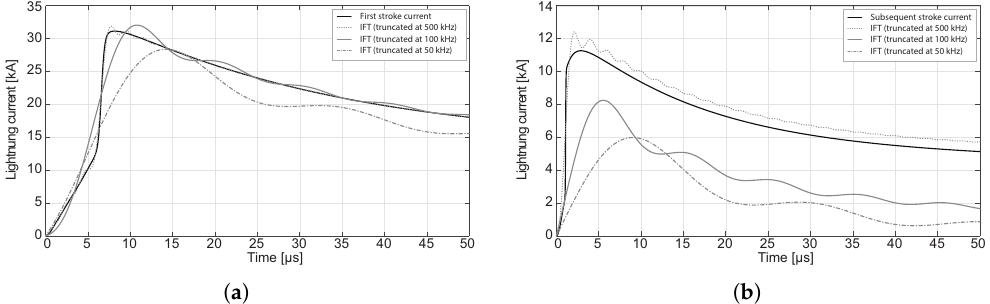
Figure 21. First and subsequent stroke currents obtained as the Inverse Fourier Transform of the frequency spectrum in Figure 20a, truncated at 500 kHz, 100 kHz, and 50 kHz. ( a ) First stroke current. ( b ) Subsequent stroke